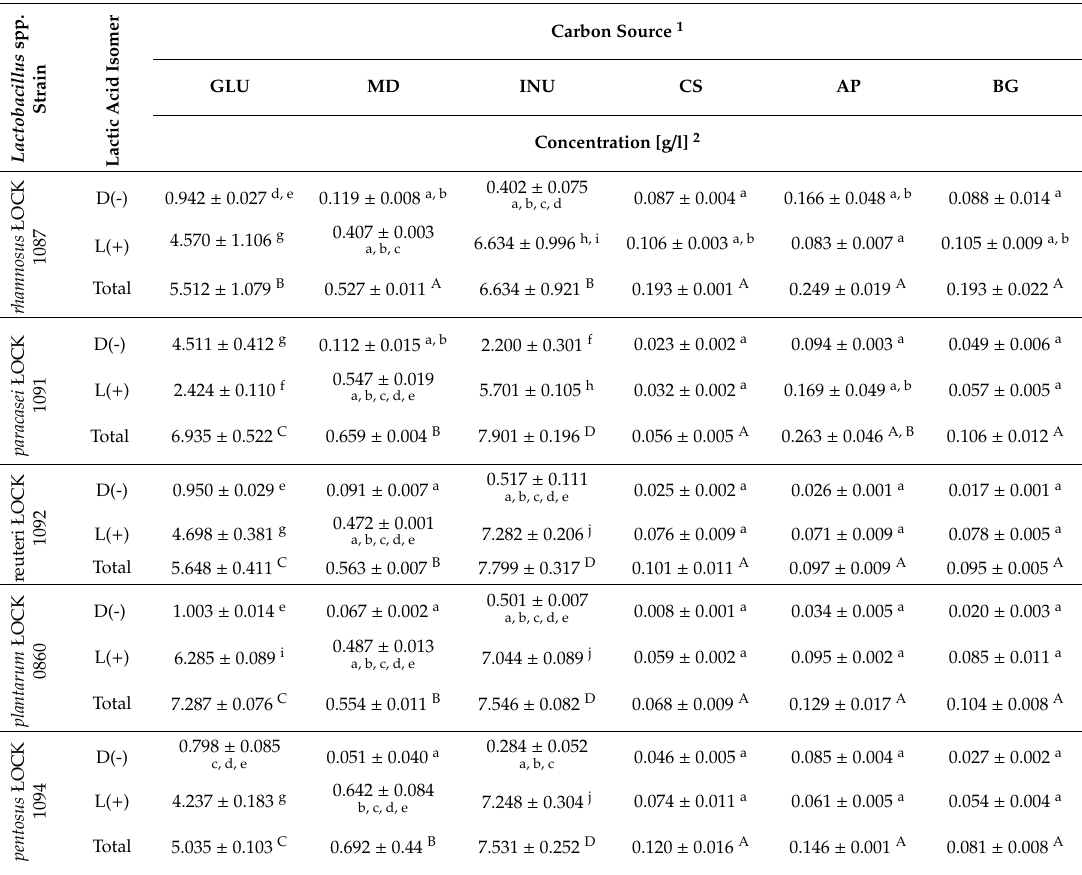
Influence of prebiotics on the synthesis of optically active forms of lactic acid by Lactobacillus spp.